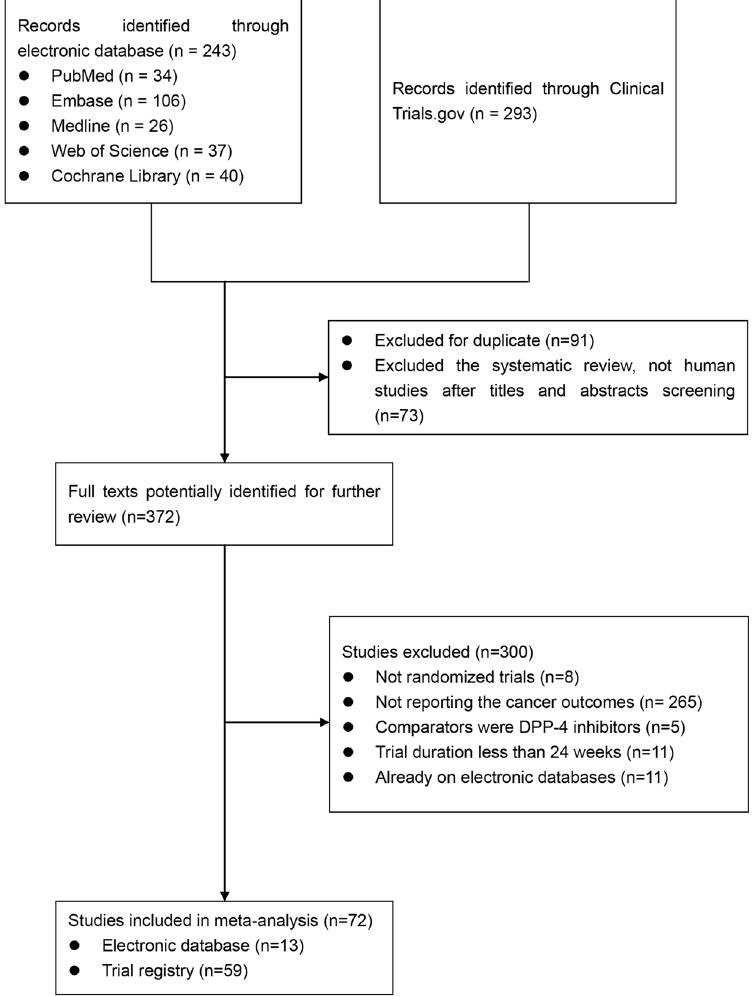
Figure 1. Flowchart of study selection process. DPP-4: dipeptidyl